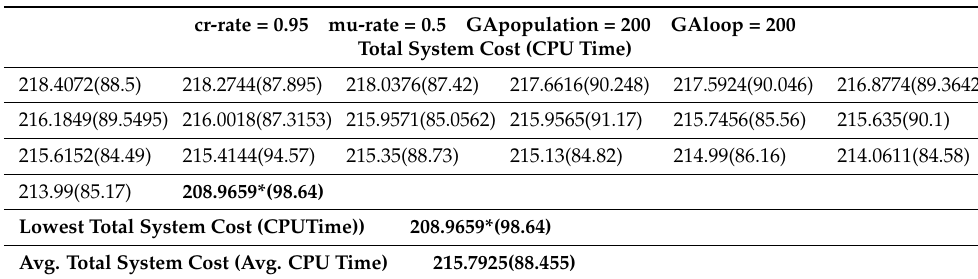
Table 23. The total system costs of 20 simulation runs obtained by MRAH–MGA for the parallel- series system.